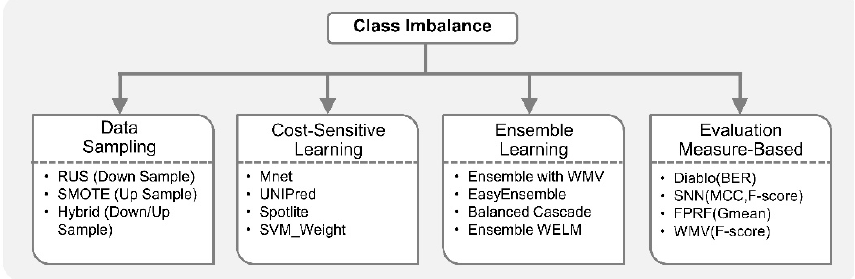
Figure 4. Machine learning with class imbalance. Class imbalance learning (CIL) methods are broadly classified into three types: data sampling, cost-sensitive learning and ensemble methods. Data sampling approaches balance the class distribution by either undersampling the majority class (e.g., random under sampling (RUS)), oversampling the minority class (e.g., synthetic minority oversampling technique (SMOTE)), or a combination of both (hybrid). Algorithm modification methods modify the learning algorithm generally by cost-sensitive weighting (e.g., Mnet, unbalance-aware network integration and prediction of protein functions (UNIPred), Spotlite and support vector machine (SVM)_weight). Cost-sensitive learning assigns a higher misclassification cost to minority class samples compared to majority class samples. Ensemble learning approaches like ensemble with weighted majority voting, EasyEnsemble, Balanced Cascade, and ensemble weighted extreme learning machine (WELM) train multiple classifiers, and aggregate their results to get the final output. Many existing integrative methods tackle imbalance by tuning models based on imbalance-aware evaluation measures. For example, data integration analysis for biomarker discovery using latent components (Diablo), super-layered neural network architecture (SNN), fuzzy pattern random forest (FPRF), and weighted majority voting (WMV) employ one or more CIL-specific evaluation measures like F-score, balanced error rate (BER), geometric mean (Gmean), Matthews correlation coefficient (MCC), area under precision-recall curve (auPRC), etc., instead of classification accuracy, to account for the bias introduced by imbalance in the